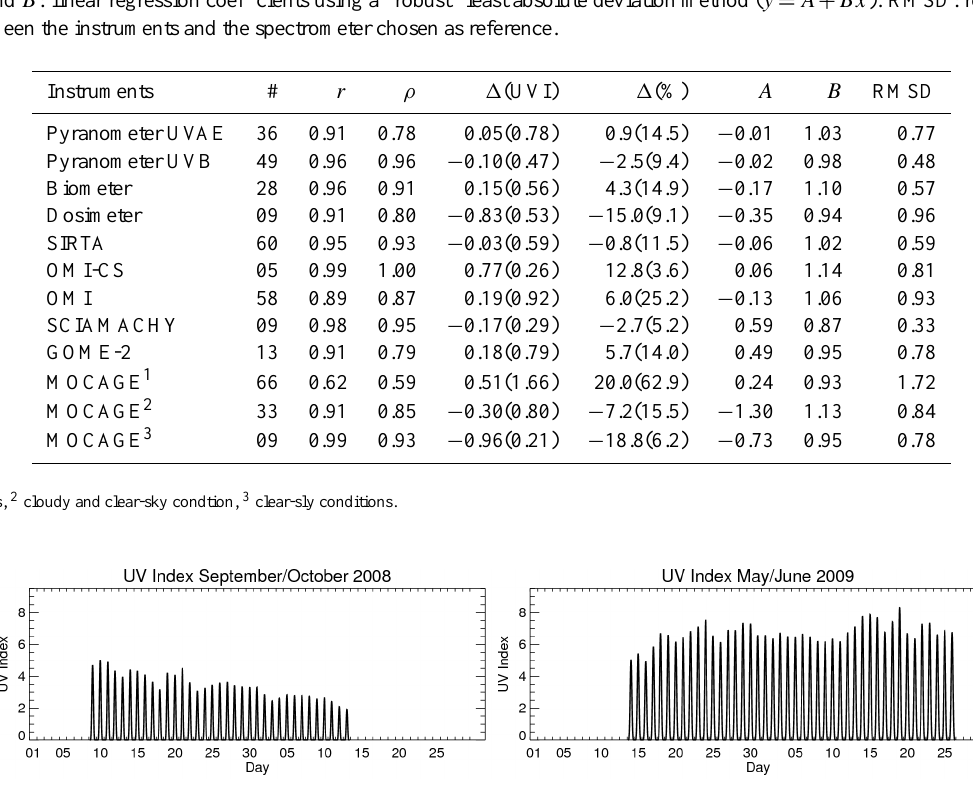
Fig. 6. TUV calculations of the UV index during the RISC-UV 1 (left) and 2 (right) campaign over Palaiseau in clear-sky